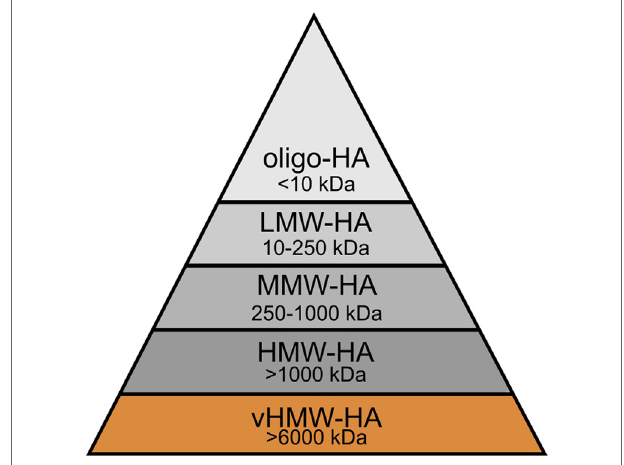
FiGURe 5 | Molecular weight groups of hyaluronan (HA) in humans and the naked mole rat. HA can be distinguished into several groups according to its